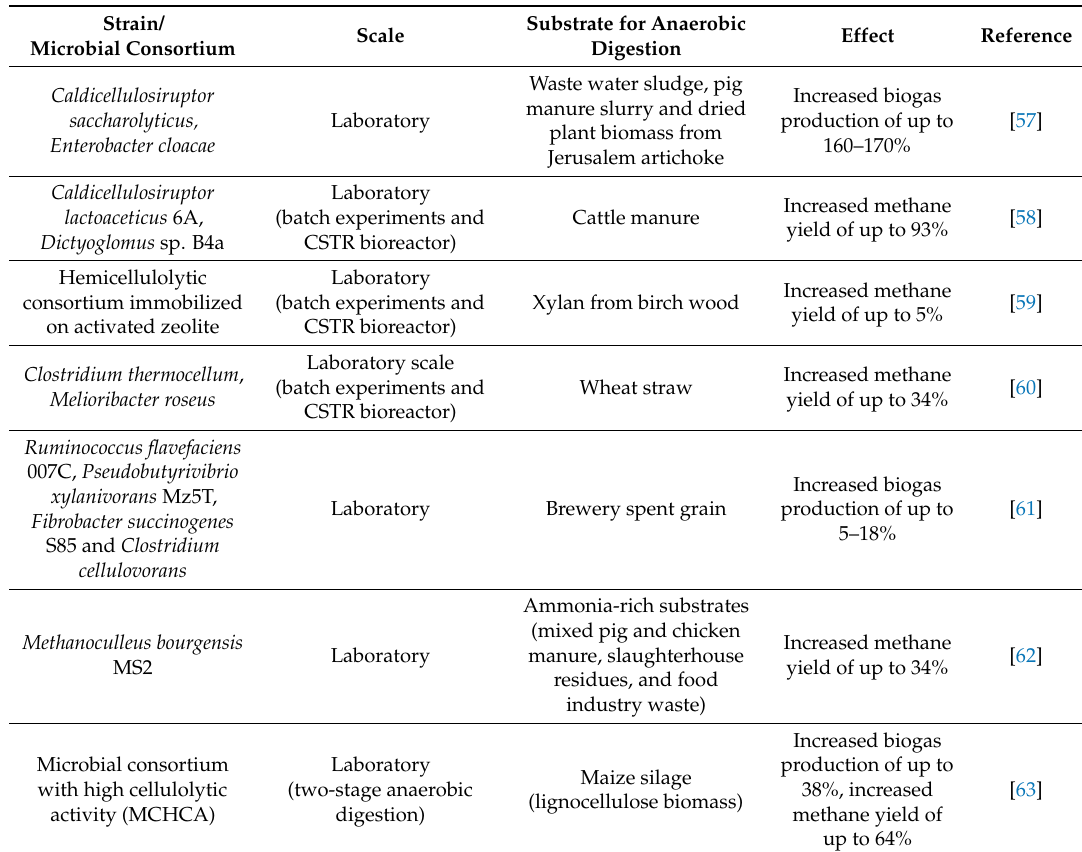
Table 1. Examples of various bioaugmentation procedures applied in anaerobic digestion of